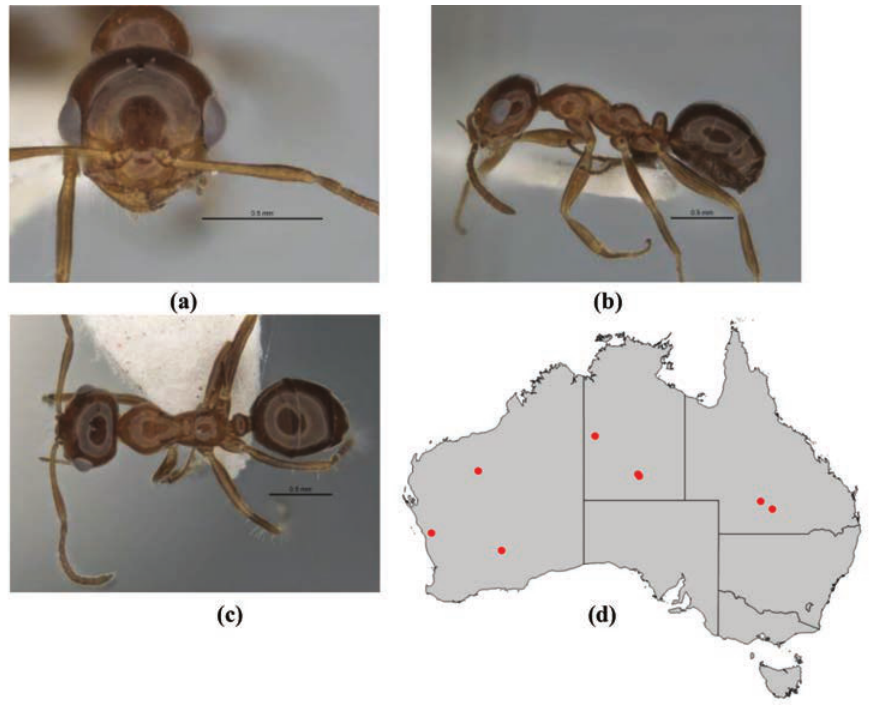
Figure 74. Melophorus vitreus sp. n.: holotype minor worker (JDM32-004585) frons ( a ), profile ( b ) and dorsum ( c ); distribution map for the species ( d ). Low resolution scale bars: 0.5 mm ( a–c